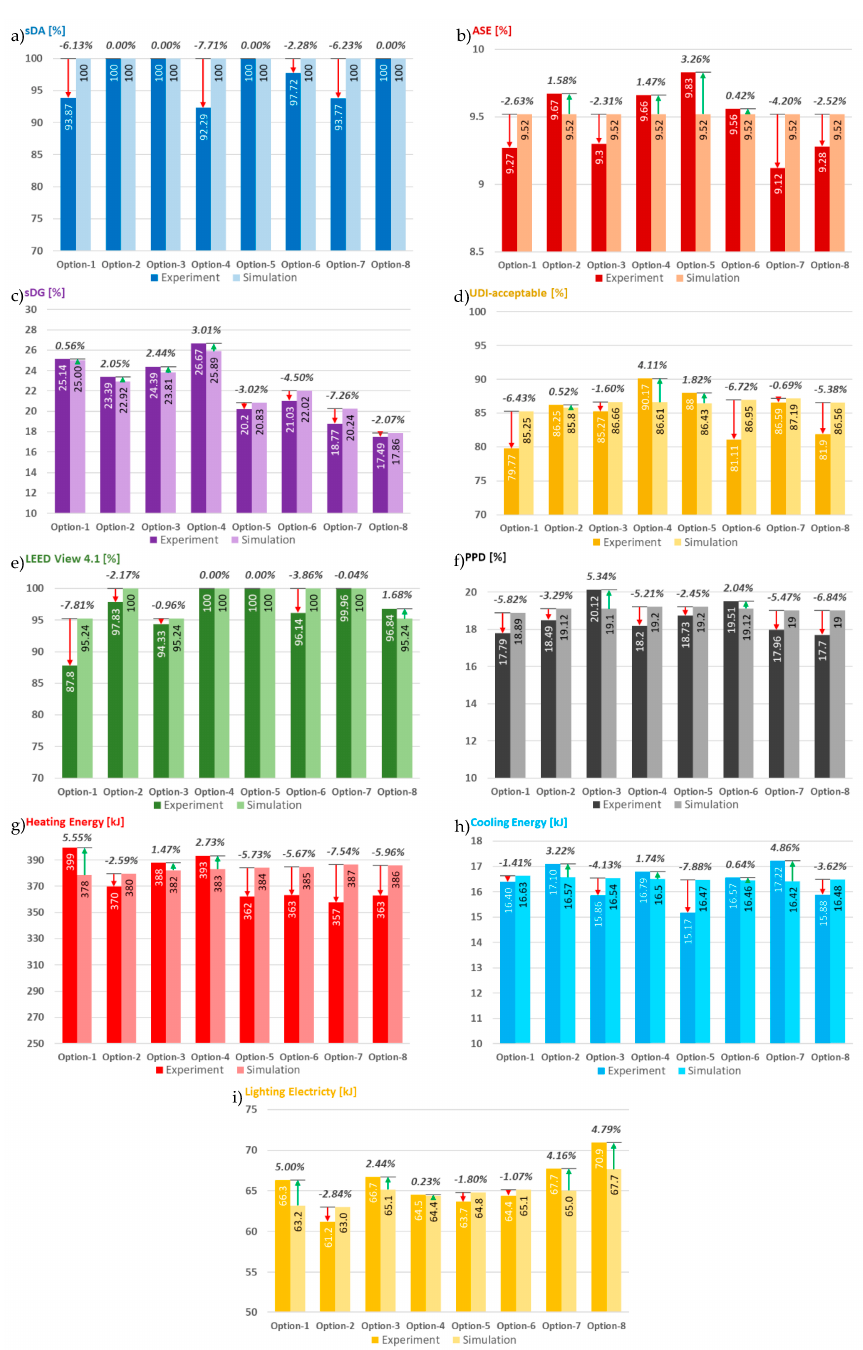
Figure 15. Comparison of simulation results and field measurement for ( a ) sDA; ( b ) ASE, ( c ) sDG, ( d ) UDI, ( e ) Leed View-v4.1, ( f ) PPD, ( g ) Heating, ( h ) Cooling, and ( i ) Lighting energy. The darker colors represent experimental measurements and lighter colors demonstrate the simulation and optimization results. The percentages next to the columns indicate the difference between simulation and field